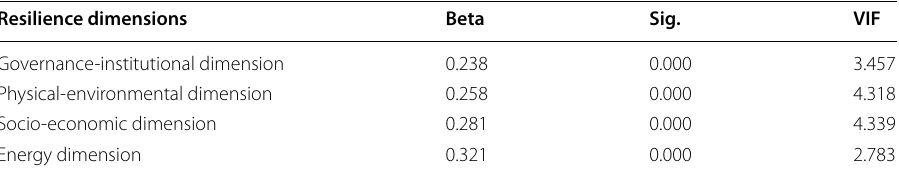
Table 9 R square analysis Resilience